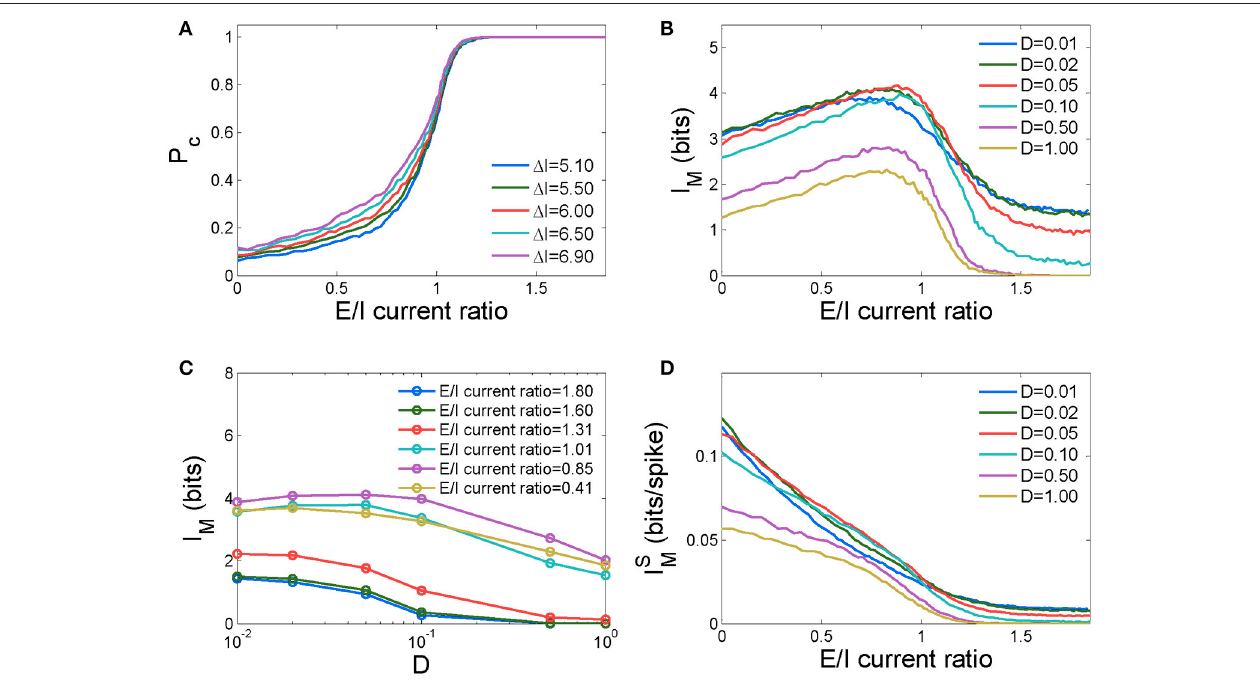
FIGURE 4 | The dependence of the information capacity of the network on the ratio of the number of excitatory neurons to the number of inhibitory neurons in the network. (A) The pulse signal detection rate as a function of the E/I current ratio for different input pulse strengths. D information as a function of the E/I current ratio for different noise intensities. (C) The mutual information as a function of the noise intensity for different E/I current ratios. (D) Mutual information per spike as a function of the E/I current ratio for different noise intensities. In the above calculations, the number of neurons N